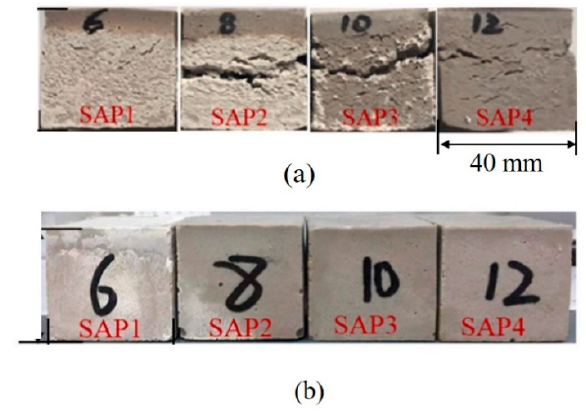
Figure 4. Appearance of ASP geopolymers cured under different curing conditions (( a ) Cured at 60 °C ( b ) Cured by the two-stage curing method (precuring at 40 °C, then cured at 60/80 °C)) [55].